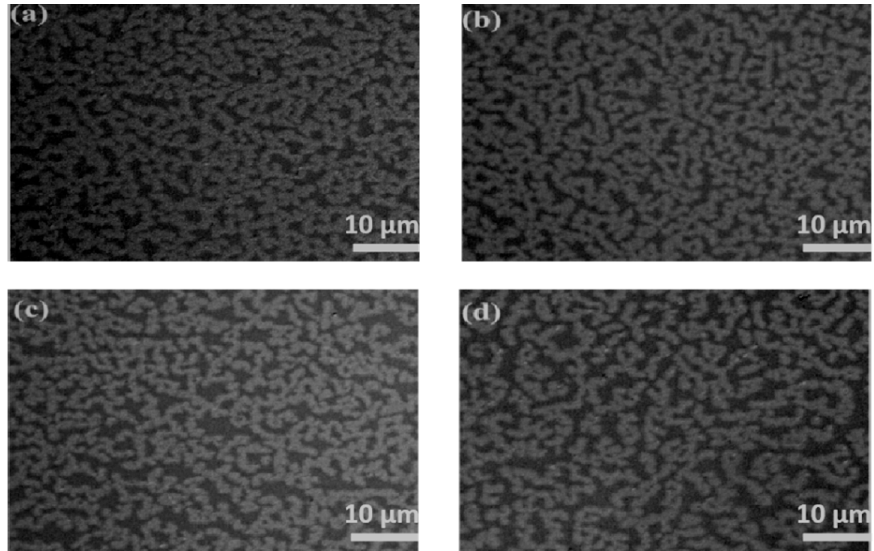
Figure 2. Morphology of 10 nm Au films deposited on silicone oil surfaces ( a ) without annealing and annealed at ( b ) 150 ◦ C, ( c ) 250 ◦ C, ( d ) 350 ◦ C,